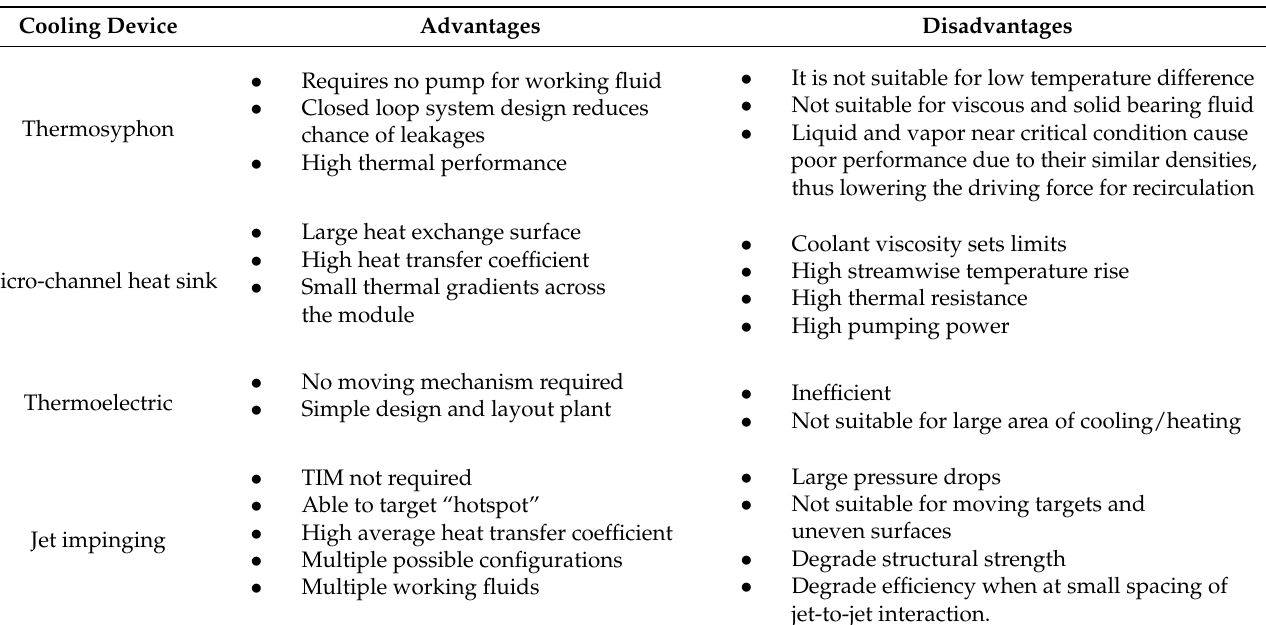
Table 1. Summary of different cooling devices with their advantages and disadvantages in ther- mal